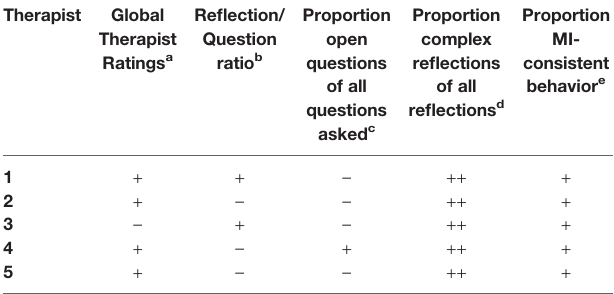
TABLE 7 | Therapist fi delity